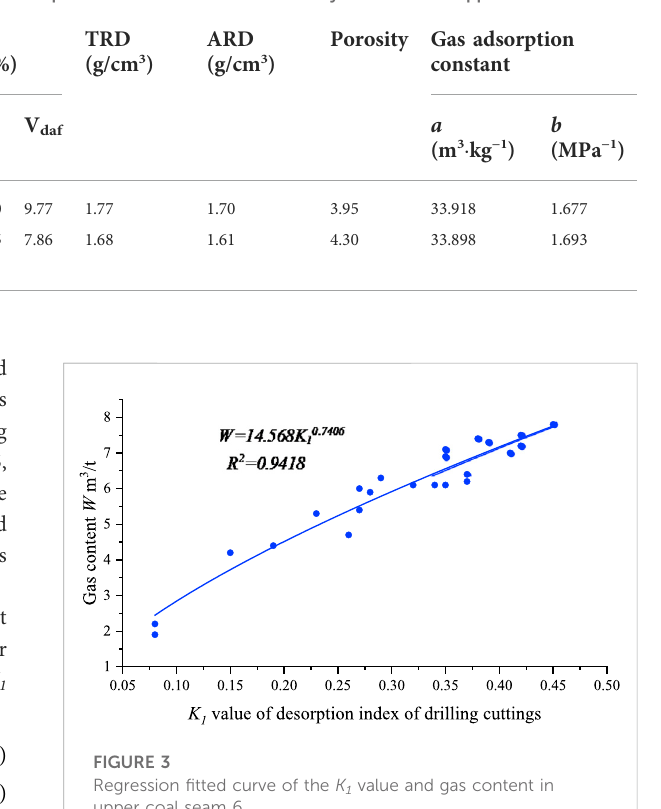
FIGURE 3 Regression fi tted curve of the K 1 value and gas content in upper coal seam